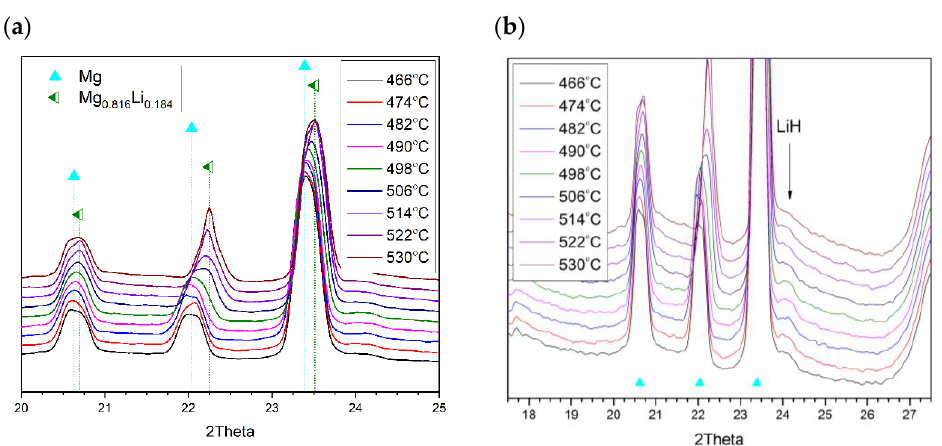
Figure 5. Formation of the Mg 0.816 Li 0.184 alloy via the reaction of lithium hydride with magnesium: ( a ) Mg 0.816 Li 0.18 peaks’ appearance; ( b ) LiH consumption. The alloy-formation process serves to diminish the intensity of the lithium hydride peak, with Li penetration into the magnesium lattice (Figure 5b), and then the higher